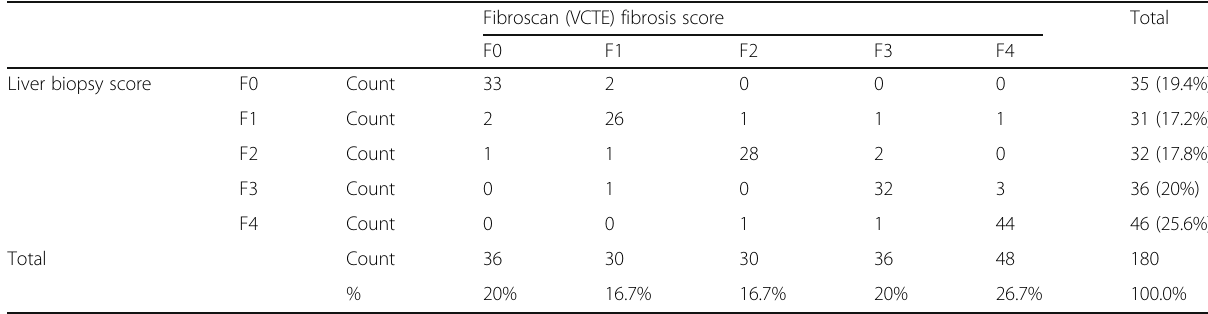
Table 2 The results of the fibroscan fibrosis score between the selected population compared to the tissue